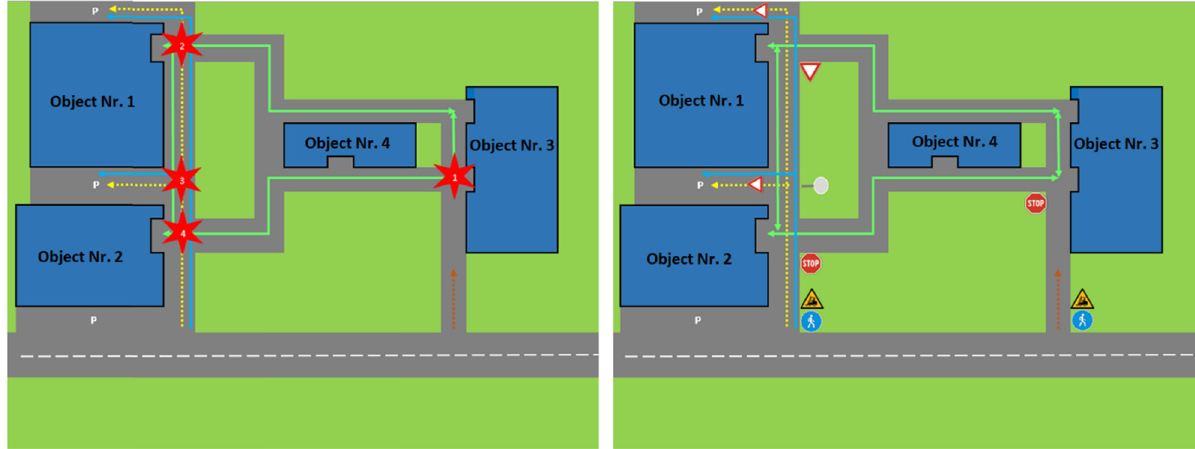
Figure 6: Points of collision and proposal for solutions to the problem of collision